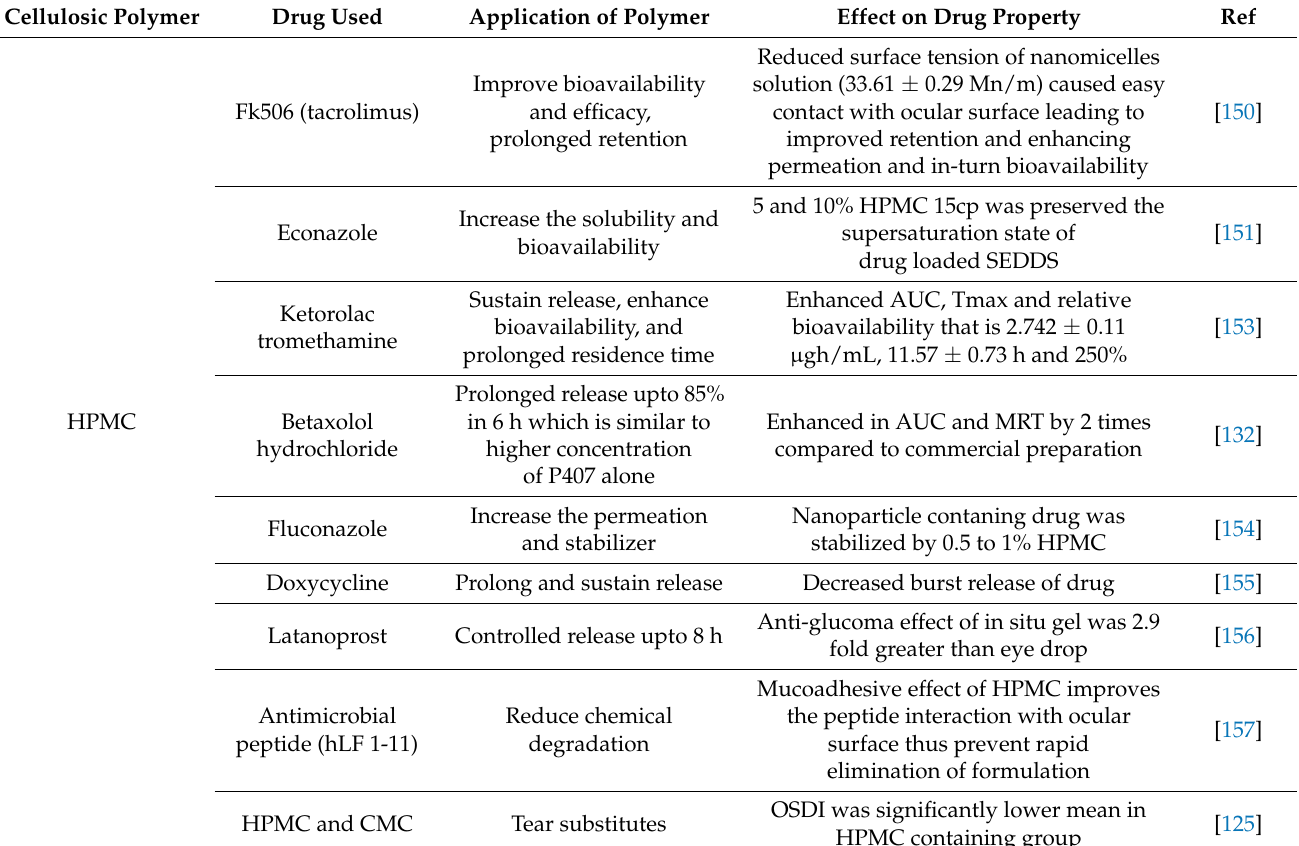
Table 3. Application of HPMC in ocular drug delivery.